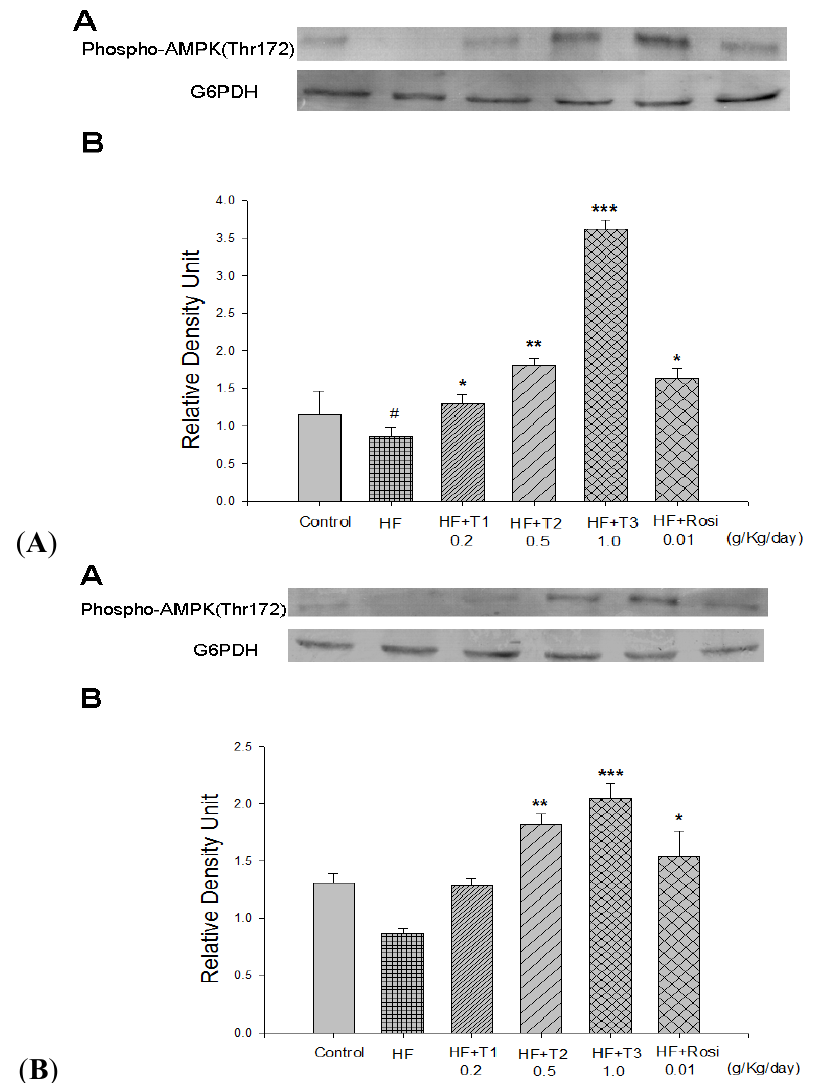
Figure 5. The phospho-AMPK (Thr172) protein contents in liver and white adipose tissue of the mice by oral gavage cell suspension culture of Eriobotrya japonica for 4 weeks. Protein was separated by 12% SDS-PAGE detected by Western blot. All values are means ± S.E. (n = 9). # p < 0.05 compared with the control (CON) group; * p < 0.05, ** p < 0.01, *** p < 0.001 compared with the high-fat (HF) + vehicle (distilled water) group by ANOVA. T1, T2, T3, cell suspension culture of Eriobotrya